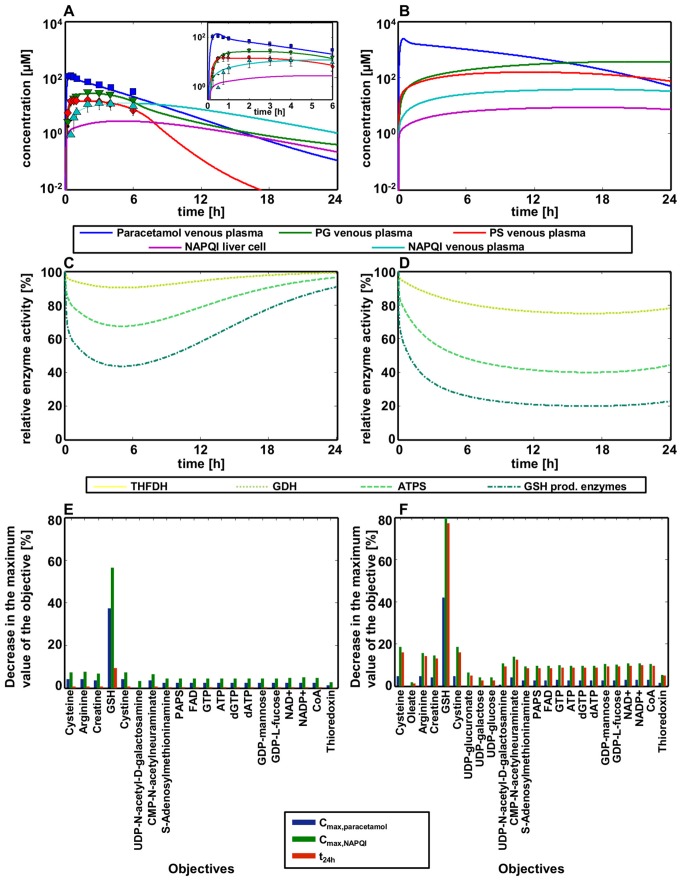
Effect of a therapeutic dose and a toxic overdose of paracetamol on liver functionality.(A) Simulated venous plasma concentration profiles of paracetamol and its three metabolites after an paracetamol dose of 1 g are in agreement with experimental PK data [65]. (B) Prediction of venous plasma concentration profiles of paracetamol and its three metabolites after a paracetamol dose of 15 g based on the 1 g application model. (C, D) Relative enzyme activity of the three impaired enzymes THFDH, GDH, ATPS and the GSH depletion are also implemented as enzyme inhibition after the application of 1 g (C) and 15 g (D) paracetamol, respectively. (E, F) Effect of the paracetamol doses of 1 g (E) and 15 g (F), respectively, on liver functionality at three different time points. Bars represent the decrease of maximum values of every objective function which undergoes a change in its maximum value.